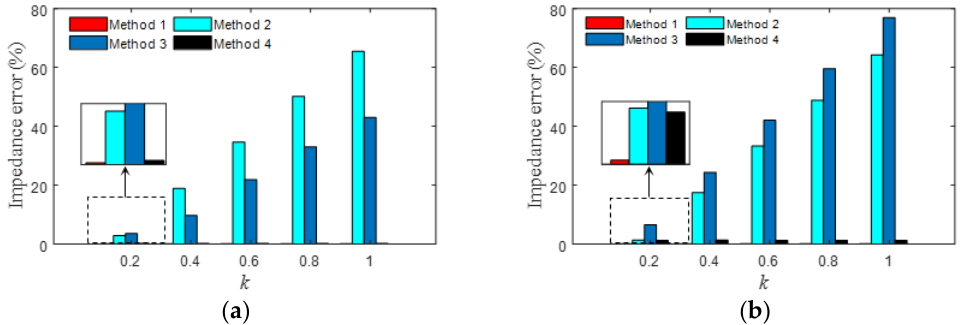
Figure 8. The error when k takes different values. ( a ) Impedance real part error; ( b ) Impedance